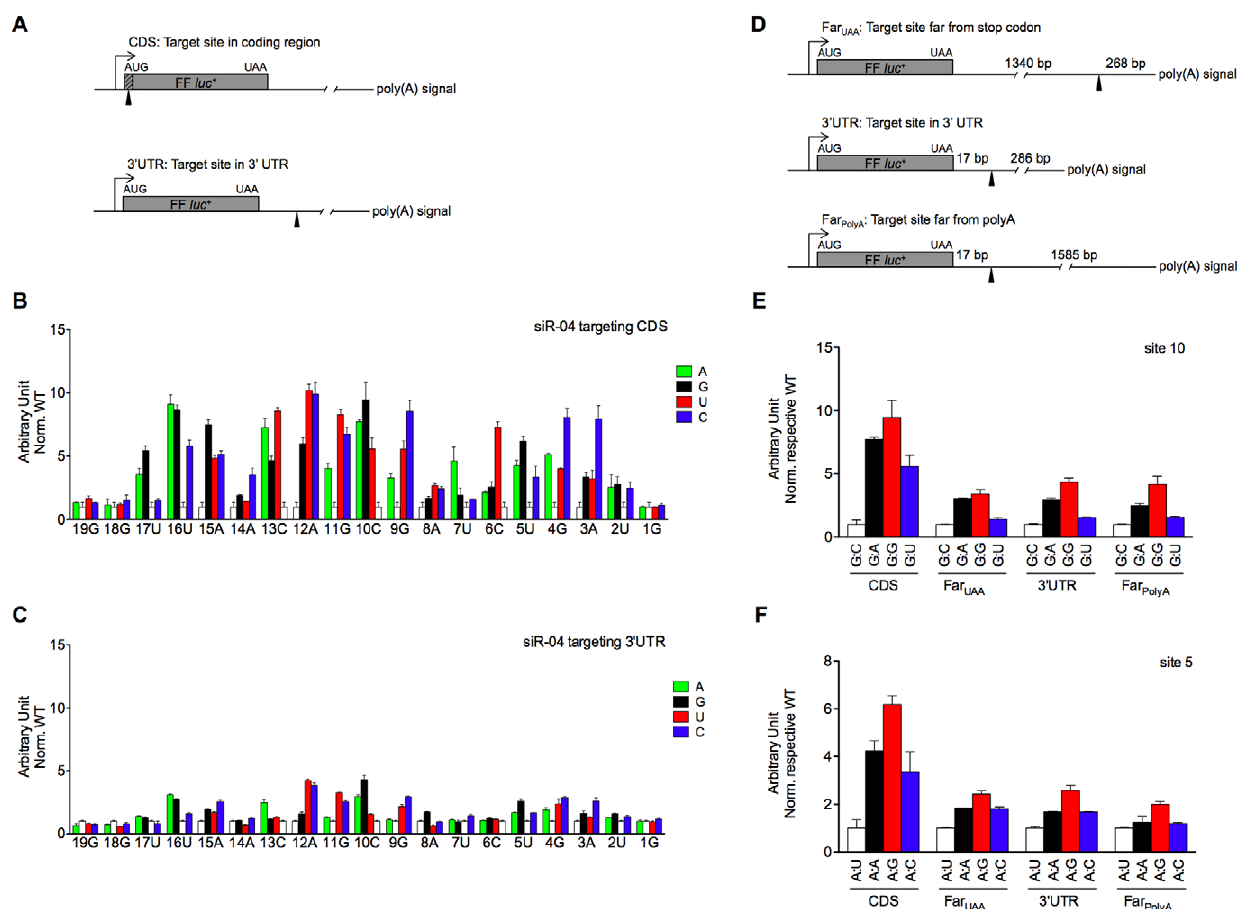
Figure 1. siRNA had greatly elevated mismatch tolerance towards 3 9 -UTR sites. (A) Schematic diagram of the fusion firefly luciferase reporter, with target site inserted in-frame in coding region (CDS) or 3 9 -UTR, respectively. In the diagram of CDS construct, shown to the left was SV40 promoter and the inserted in-frame AUG start codon, followed by a solid triangle representing the target site and the luciferase gene with authentic UAA stop codon. In the diagram of 3 9 -UTR construct, original cloning site was destroyed and grafted downstream of the stop codon. (B,C) The normalized silencing efficacies of siR-04 on single-nucleotide mismatched targets in CDS (B) or 3 9 -UTR (C). The figure was plotted against the position (numbered from the start of the siRNA antisense strand) and the identity of the mismatched nucleotides. The position and the wild-type target sequence were given under the x-axis. The y-axis represented the relative silencing efficacies of siR-04 towards mismatches (colored bars), which were normalized to siRNA towards the perfectly matched site (WT, white bars) to gain the same starting point. The lower of the bars indicated siRNA had stronger silencing activities. (D) Schematic diagram of the fusion firefly luciferase reporters, with siRNA target site inserted at different positions relative to the stop codon and poly(A) signal in 3 9 -UTR. The distances between the target site and the stop codon/poly(A) signal were indicated. (E,F) The normalized silencing efficacies were measured with different vectors harboring siRNA target sites in CDS or at different locations within the 3 9 - UTR. The target site location and siRNA:mRNA match pattern were given under the x-axis. The y-axis was similar with B and C, which was normalized to each WT construct at either location. Two sites were picked up, site 10 in (E) and site 5 in (F). Error bars represented SD. Data were average values of assays in triplicates, and all experiments were repeated at least